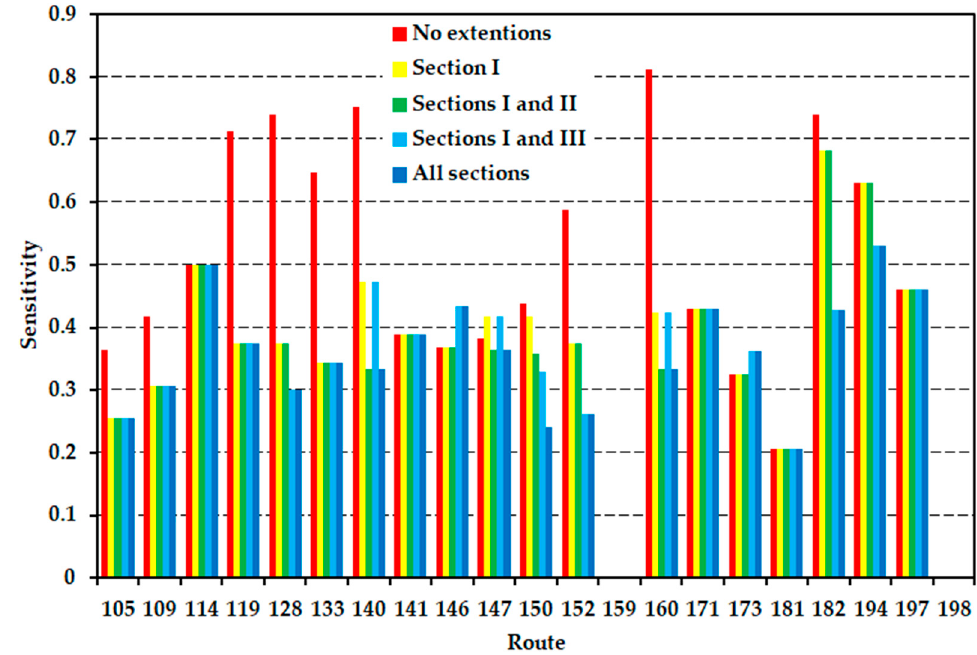
Figure 11. The value of the sensitivity coefficient (source: own elaboration).